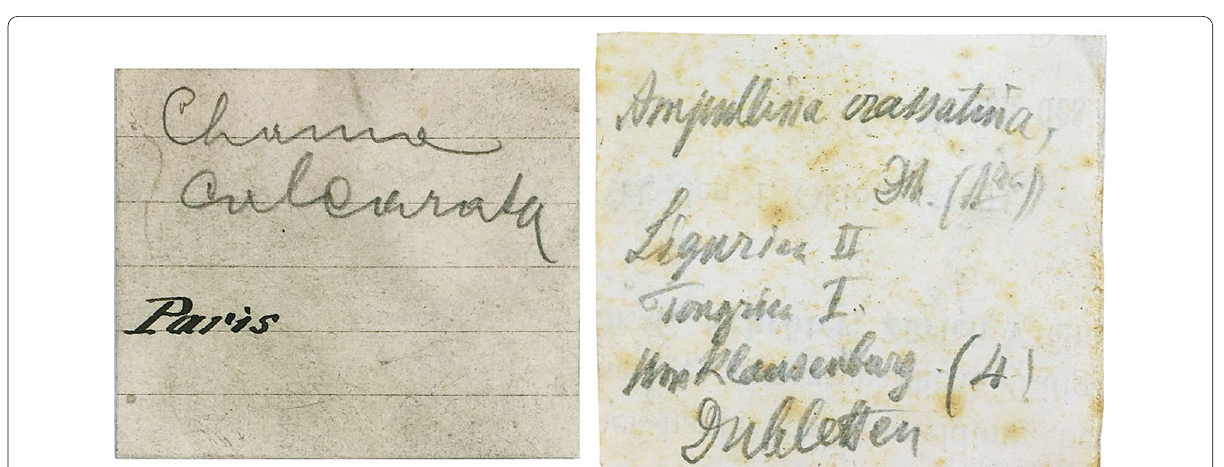
Fig. 8 Two examples of “field” labels; left of Chama calcarata Lamarck, 1806; right of Ampullina carassatina (Lamarck,